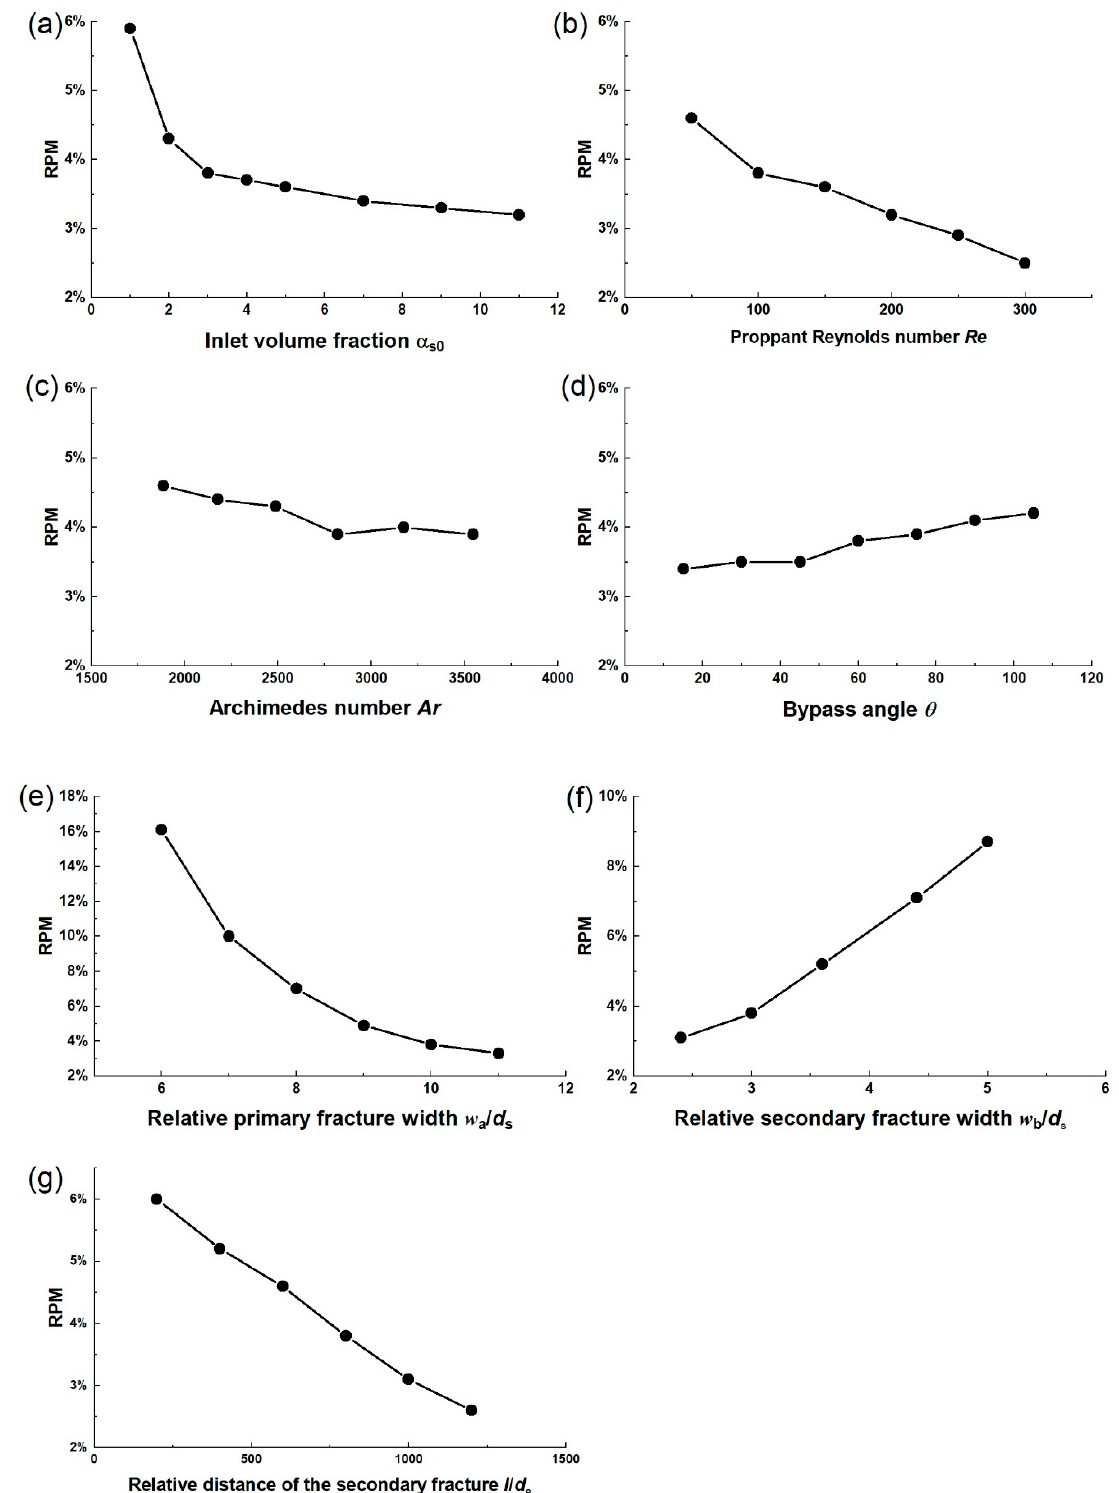
Figure 7. The curve of ratio of the proppant mass (RPM) with the dimensionless parameters, ( a ) inlet proppant volume fraction, ( b ) proppant Reynolds number, ( c ) Archimedes number, ( d ) angle between primary and secondary fracture (bypass angle), ( e ) relative width of primary fracture, ( f ) relative width of secondary fracture, and ( g ) relative distance of secondary fracture to primary fracture entrance.